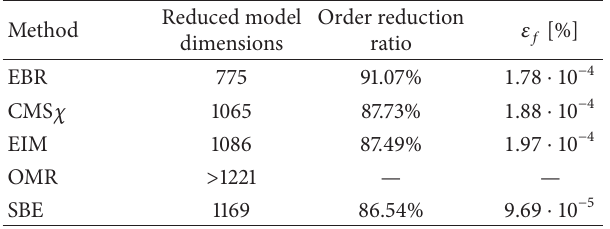
Figure 5: Logarithmic plot of MAC (a) and 𝜀 𝑔 (b) versus number of interior modes. Table 1: Dimensions of the reduced models ensuring MAC ≥ 0.999 and 𝜀 𝑔 ≤ 1% for each